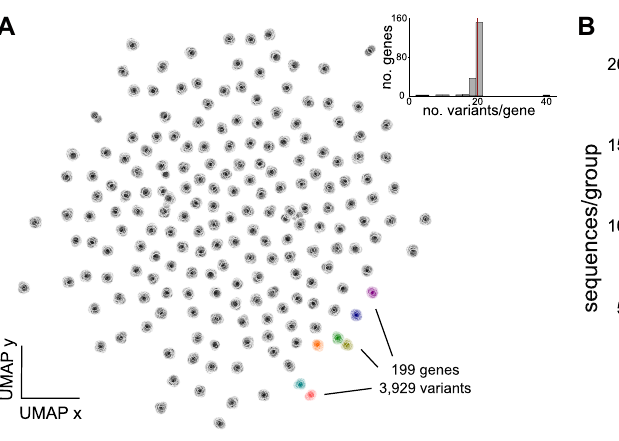
Fig. 6 | Sequence-to-expression models using promoter data from Sacchar- omycescerevisiae .A GenotypicspaceofyeastpromoterdatafromVaishnavetal. 25 visualized with the UMAP 27 algorithm for dimensionality reduction; sequences were featurized using counts of overlapping 4-mers, as in Fig. 1B. The dataset contains 3929 promoter variants (80nt long) of 199 native genes, as well as fl uor- escence measurements of a yellow fl uorescent protein (YFP)reporter;insetshows thedistributionofvariantspergeneacrossthewholedataset. B Bubbleplotsshow theaccuracyof fi verandomforest(RF)modelstrainedondatasetsofconstantsize andincreasingsequencediversity,followingasimilarstrategyasinFig.5A.We fi rst aggregated variant clusters into twelve groups, and then trained RF models by